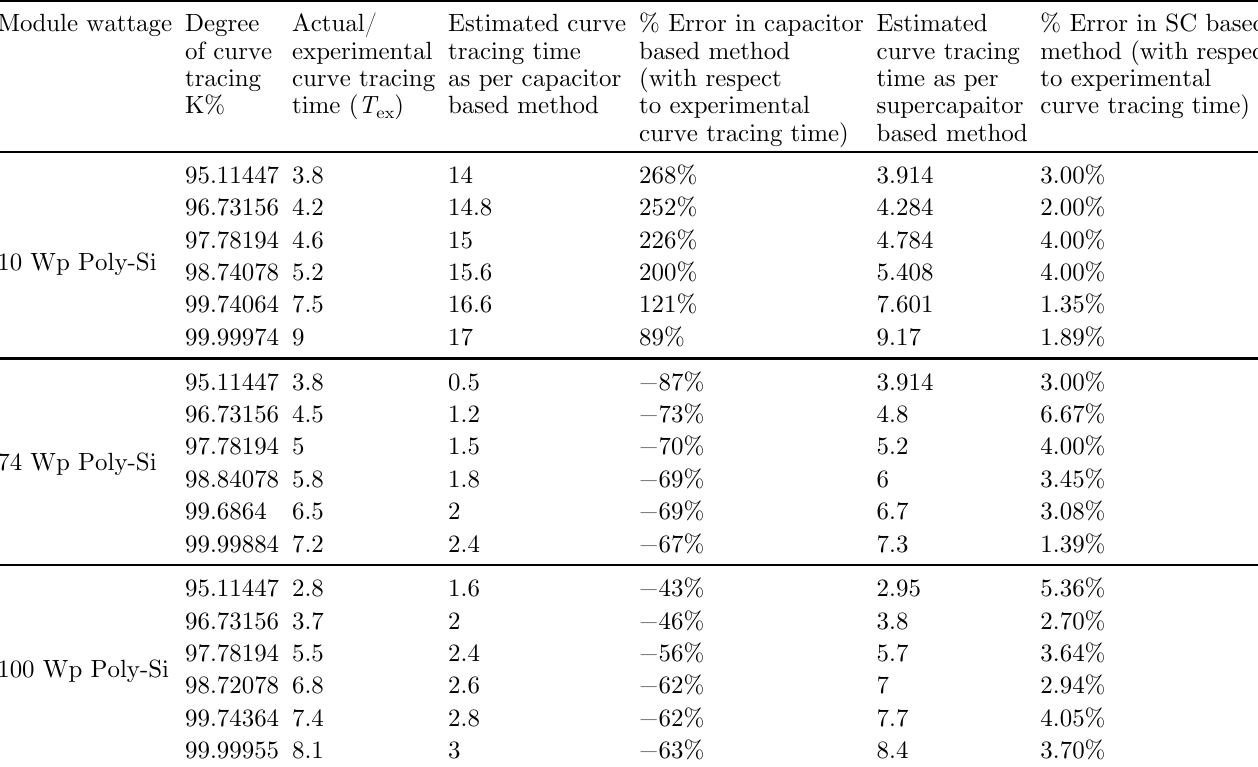
Table 1. Estimate of curve tracing time (for 10Wp, 74Wp and 100Wp poly-Si PV module).